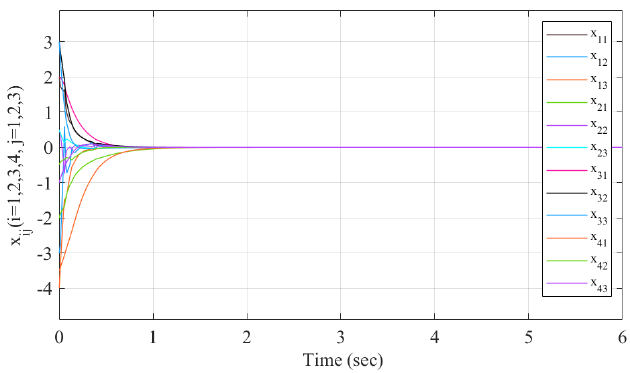
Figure 3. Tracking error trajectories of nodes without DoS